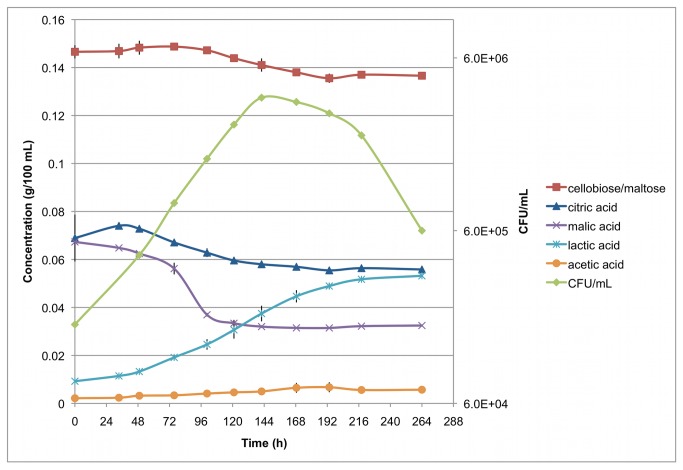
HPLC analysis of beer during Pc344-358 growth.Estimated concentrations of each compound were determined over time and plate counts were used to measure bacterial growth. Triplicate growth curves were analyzed, and standard deviations are indicated with error bars. Cellobiose and maltose could not be differentiated on the HPLC column, and are thus grouped together. Dextrin, ethanol, and glucose data are not included, as no change in concentration was found, or it was too low to detect (i.e., glucose).